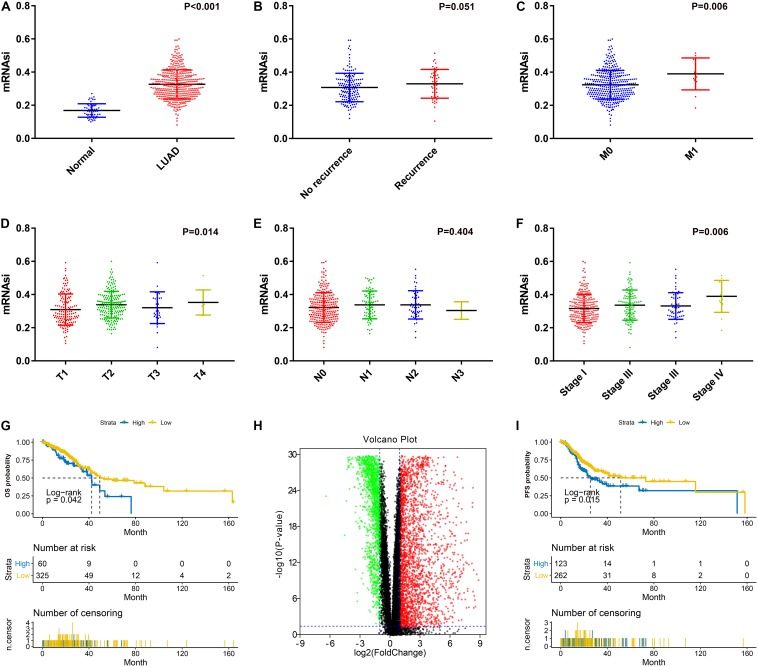
(A) Differences in mRNAsi between normal (57 samples) and LUAD (385 samples) tissues. (B) Differences in mRNAsi between LUAD patients without recurrence (154 samples) and with recurrence (46 samples) after primary treatment without adjuvant therapy. (C) Differences in mRNAsi between LUAD patients with M0 (370 samples) and M1 (15 samples) stage. (D) Comparison of mRNAsi in four different T stages (T1, 124 samples; T2, 75 samples; T3, 32 samples; T4, 9 samples). (E) Comparison of mRNAsi in four different N stages (N0, 260 samples; N1, 75 samples; N2, 48 samples; N3, 2 samples). (F) Comparison of mRNAsi in four different AJCC stages (Stage I, 215 samples; Stage II, 99 samples; Stage III, 56 samples; Stage IV, 15 samples). (G) Kaplan–Meier curves show that the low mRNAsi group had a better prognosis than the high mRNAsi group for OS. (H) Volcano map of differentially expressed genes; green indicates downregulated genes, and red indicates upregulated genes. (I) Kaplan–Meier curves show that the low mRNAsi group had a better prognosis than the high mRNAsi group for PFS. LUAD, lung adenocarcinoma; mRNAsi, mRNA expression-based stemness index; AJCC, American Joint Committee on Cancer; OS, overall survival; PFS, progression-free survival.